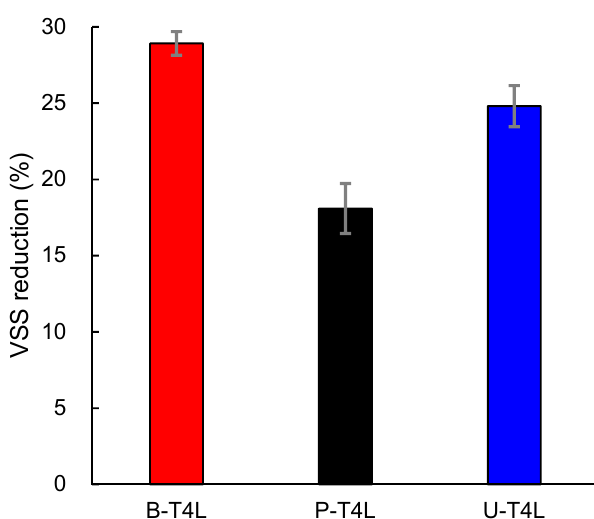
Figure 2. Volatile suspended solid reductions after 72 h treatment of the bacteriophage T4 lysozyme. B-T4L: Busan; P-T4L: Pohang; U-T4L: Ulsan.